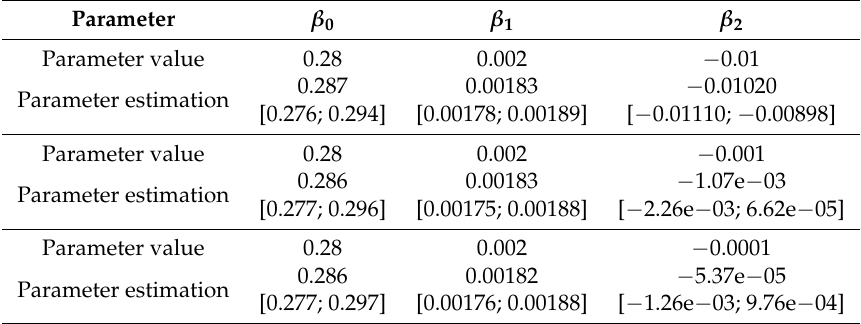
Table 4. Results of estimation using simulated dataset. Parameter used to model the dataset (parameter value), median and 90% confidence interval of the estimated